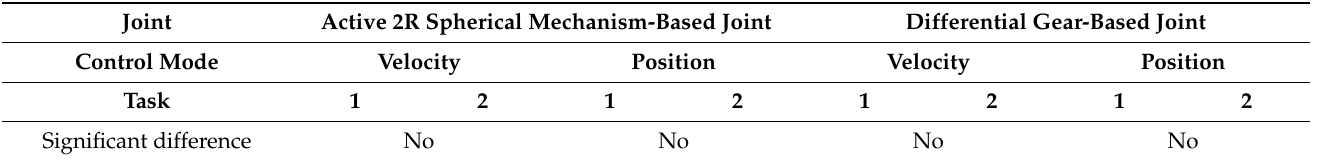
Table 1. Results of the statistical analysis of tasks one and two in two control modes.